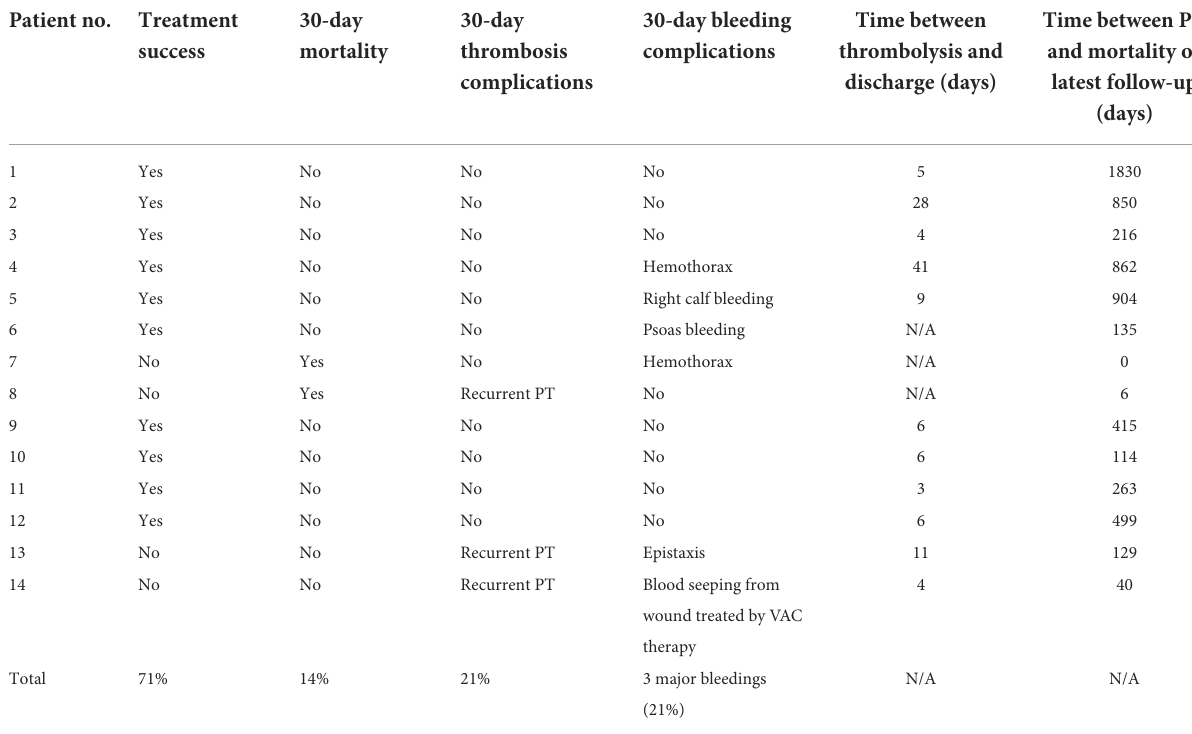
Treatmentsuccess,and30-daymortality,thrombosisandbleedingcomplicationsaftersystemicthrombolysisareshown.Moreover,timesbetweenPTlatestfollow-upand-dischargeand times between PT and mortality are depicted. Patient 14 has been discharged at day 4 following systemic thrombolysis. Flow and power returned to baseline levels. However, within 30 dayshepresentedwitharecurrentpumpthrombosisandthereforethereisnotreatmentsuccessasdefinedby“patientaliveat30daysfollow-upandfreeofrecurrentPT,strokeordevice exchange”.HeunderwentrecentreversalofhisoralanticoagulationbecauseofsurgicaldrainageandVACplacementbecauseofadrivelineinfection.